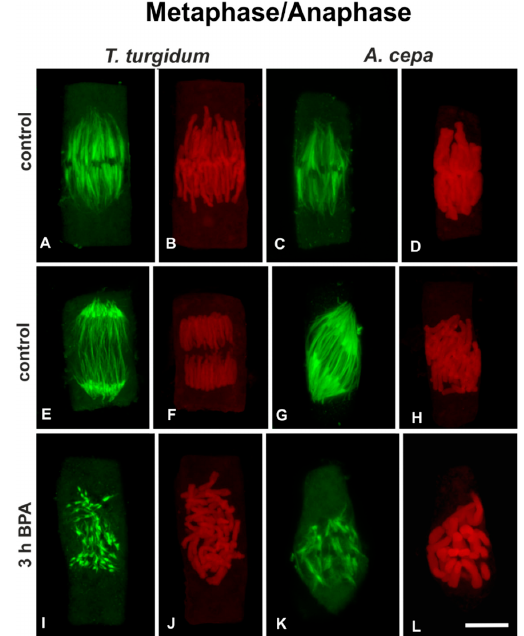
Figure 4. ( A , C , E , G , I , K ) Tubulin immunolocalization (green) and ( B , D , F , H , J , L ) propidium iodide DNA staining (red) in untreated metaphase ( A – D ) and anaphase ( I – L ) cells, as well as BPA-affected mitotic I – L ) root cells. In BPA-treated cells the metaphase or anaphase status could not be distinguished. All images are projections of CLSM sections. Scale bar: 10 μ m. Biomolecules 2019 , 9 , x FOR PEER REVIEW Telophase/cytokinetic cells of untreated roots displayed typical phragmoplasts (Figure 5A–D) developing between the daughter nuclei (Figure 5B, D). In cells of both species treated with 50 mg/L BPA for 1 h and 3 h, the phragmoplasts appeared strongly affected, disordered, branched, misaligned, or compacted (Figure 5E–L), located between abnormally segregated and atypically positioned daughter nuclei (Figure 5F, H, J, L). After 5 h of treatment, phragmoplasts were discontinuous and fragmented (Figure 5M–P), and the daughter nuclei were atypically separated in both species (Figure 5N, P). These distorted phragmoplasts, as revealed by immunofluorescence, were a first and strong indication of defective cytokinesis.